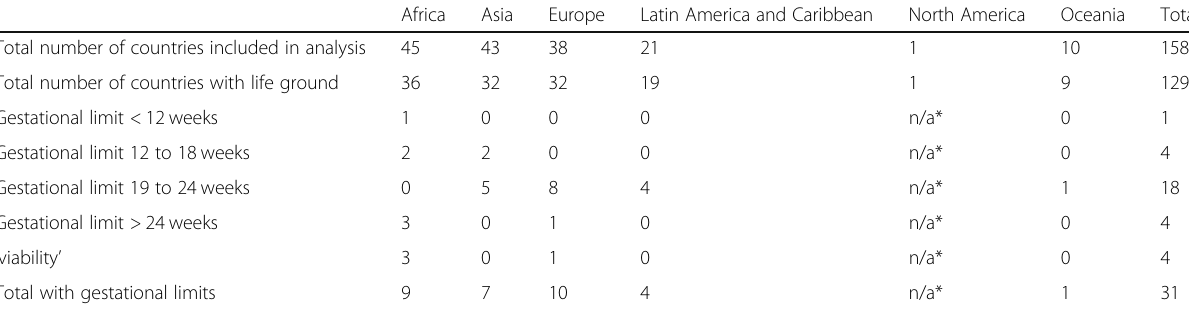
Table 1 Regional data: Life ground and associated gestational limits